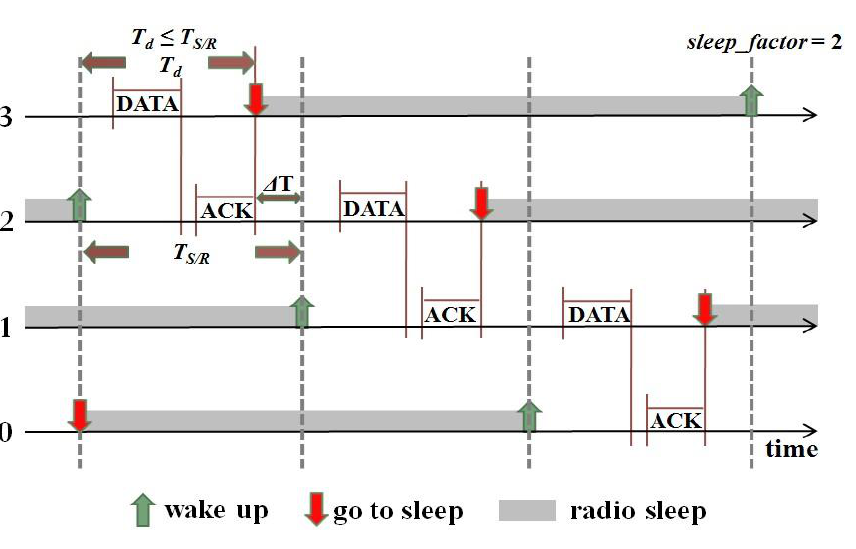
Figure 3. An example illustration of sleep_factor , data transmission route: 3  2  1 